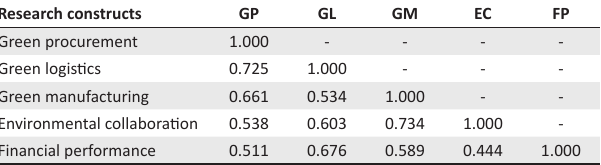
TABLE 4: Correlations between constructs. Research